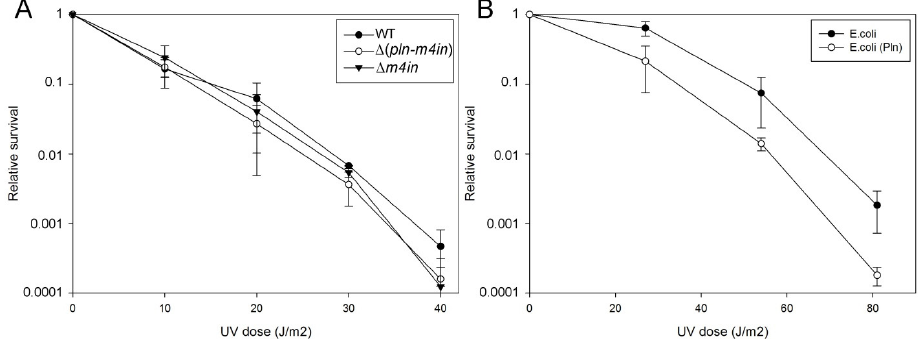
Figure 4. UV survivability of bacteria ( A ). UV survivability of wild-type S. proteamaculans (WT, black circles), and mutant S. proteamaculans with an in-frame deletion of both genes of the protealysin operon ( ∆ (pln-m4in) , open circles) and with an in-frame deletion of the emfourin gene ( ∆ m4in , black triangles). ( B ). UV survivability of E. coli AB1157 transformed with the control plasmid (black circles) and the plasmid carrying the protealysin gene (open circles).